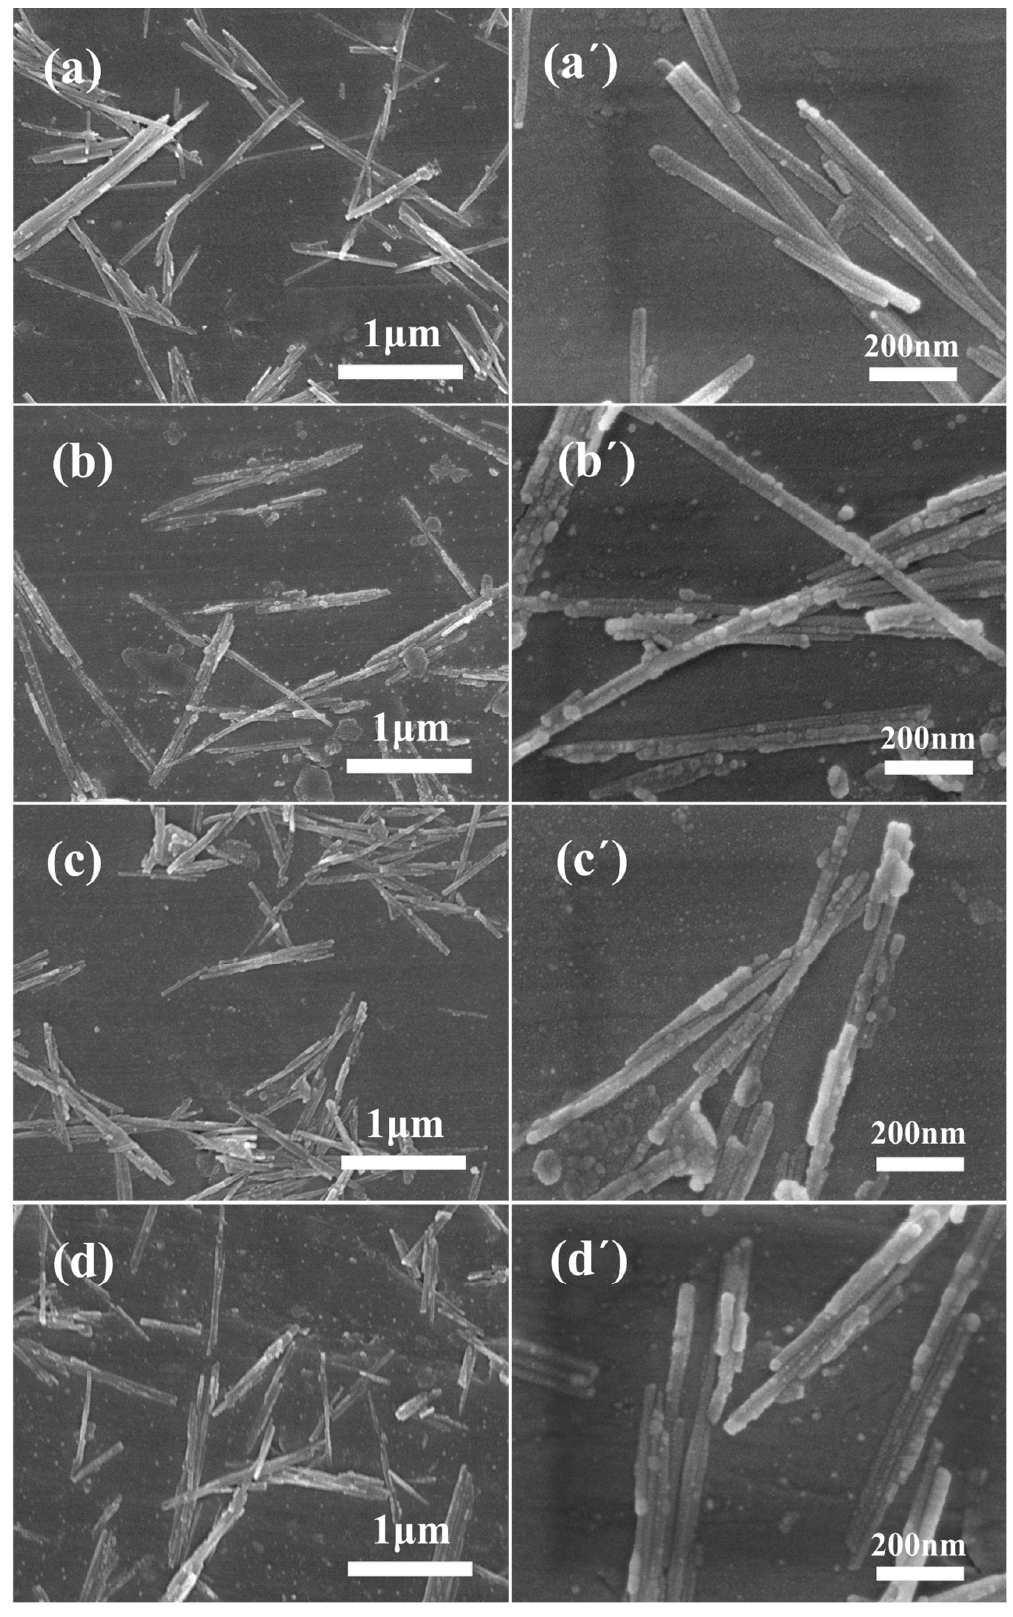
Figure 3. Microscopic morphology of sepiolite and silane-modified sepiolites. ( a , a ′ ) Sep, ( b , b ′ ) VTES − Sep, ( c , c ′ ) MPTES − Sep, and ( d , d ′ ) TESPT − Sep (left ×20,000, right ×100,000).